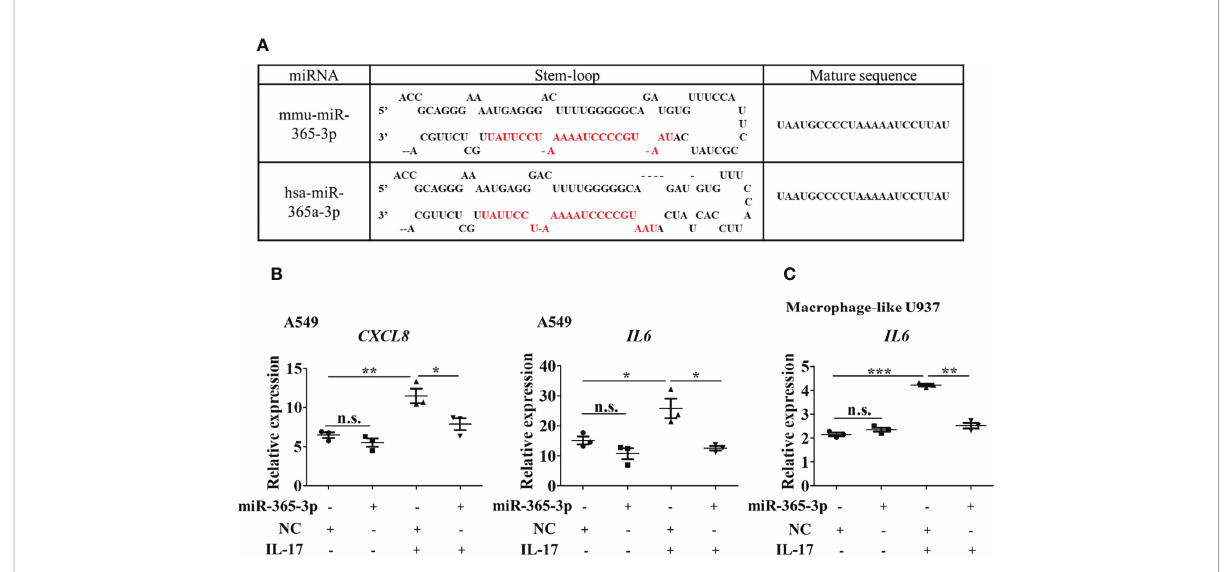
FIGURE 5 miR-365-3p also serves as a negative regulator in hIL-17 induced in fl ammatory response in human airway epithelial cells and macrophages. (A) Sequence comparison of mmu-miR-365-3p and has-miR-365a-3p. (B) Effect of miR-365-3p mimic on mRNA expression of IL-8 and IL-6 in human A549 cells upon hIL-17 treatment. N=3. (C) Effect of miR-365-3p mimic on mRNA expression of IL-6 in PMA-differentiated U937 cells upon hIL-17 treatment. N=3. *, P<0.05, **,P<0.01, ***, P<0.001. n.s., not statistically signi fi